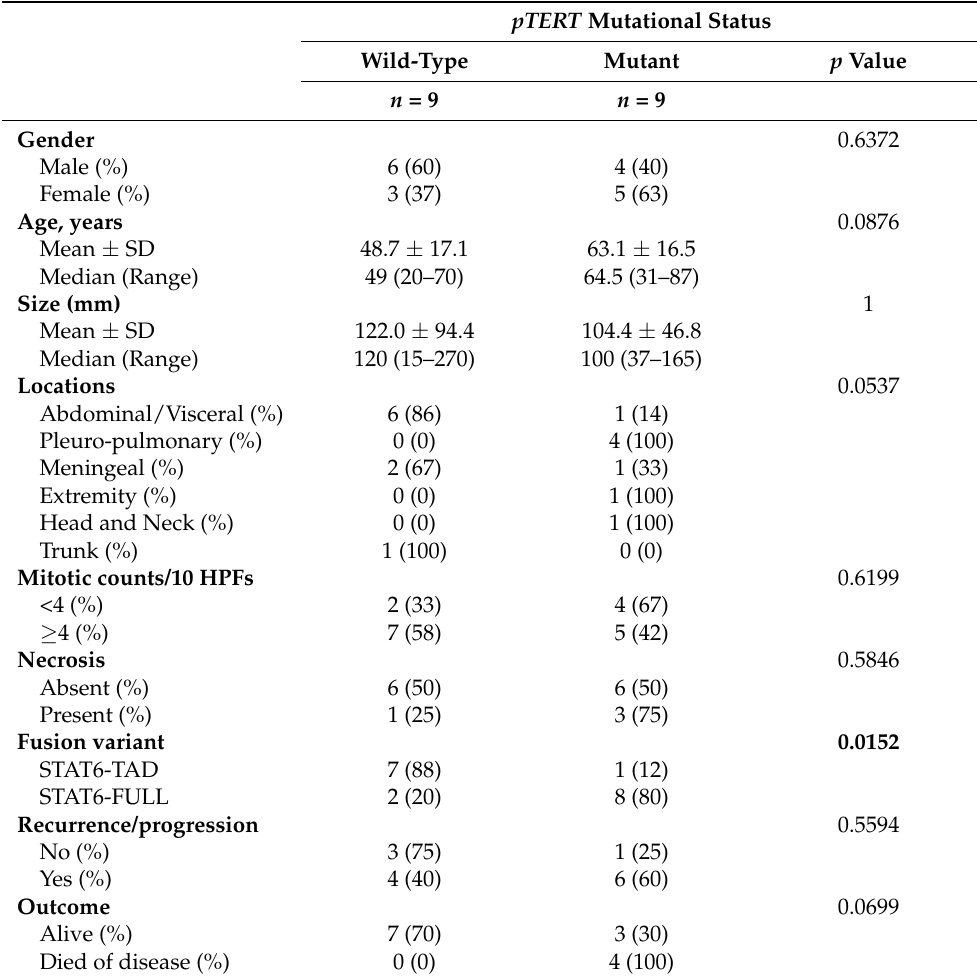
Table 4. Associations of TERT gene promoter mutations with clinicopathological parameters and gene fusion